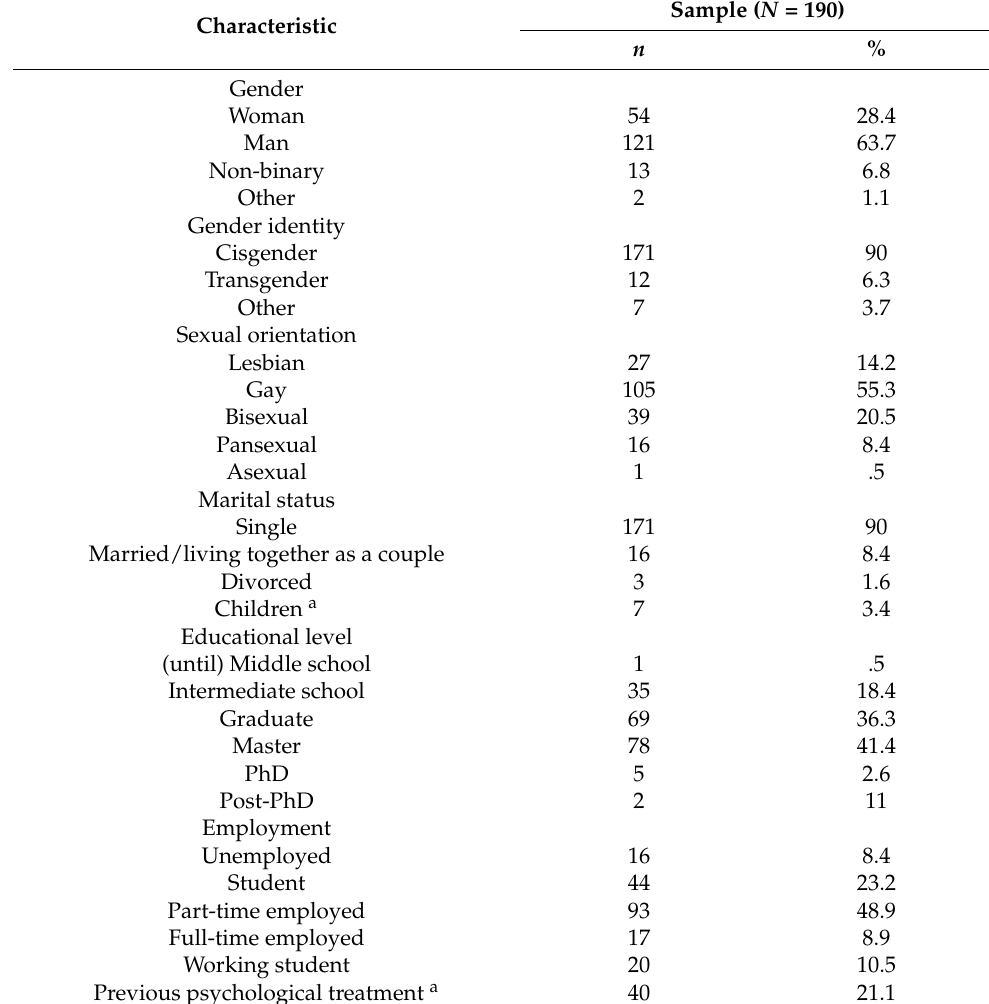
Table 1. Participants’ sociodemographic